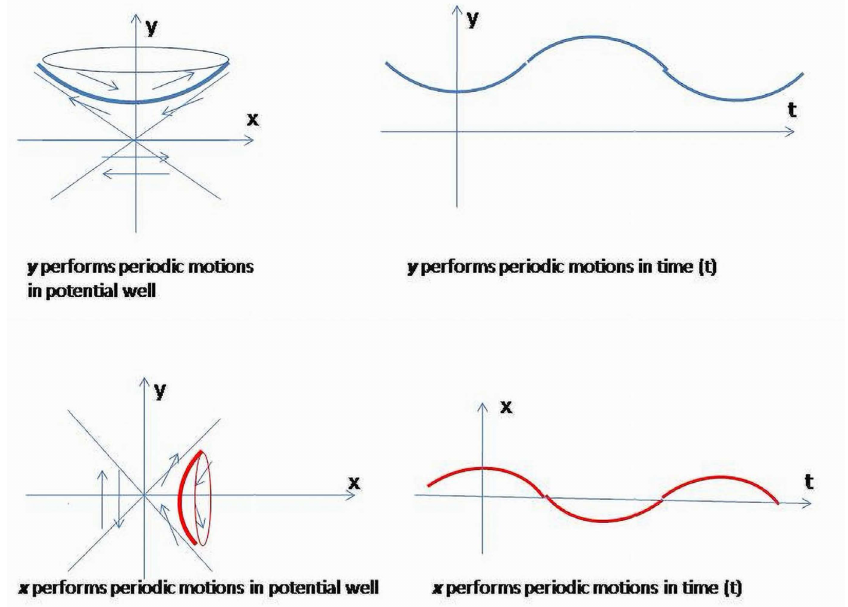
Figure 13. Behavior of the energy (entropy) components associated with negative and positive values of quadratic function <h,h> = w 2 + x 2 − y 2 − z 2